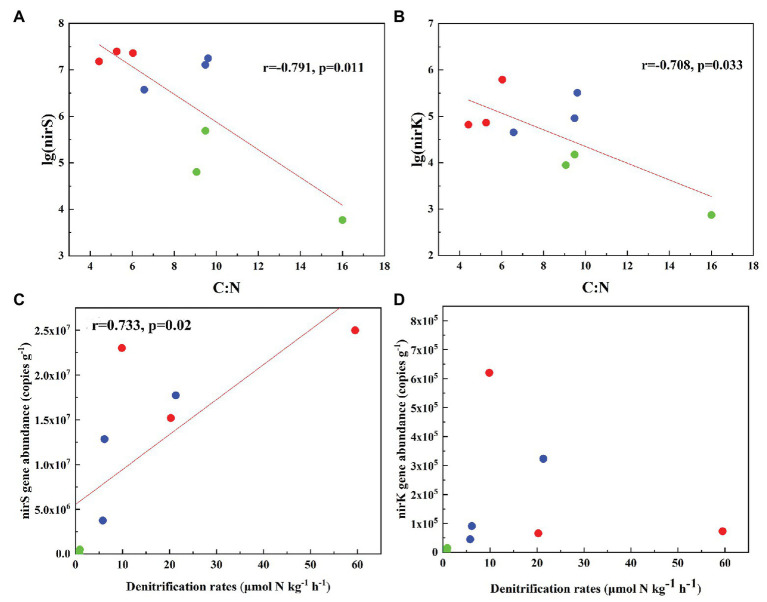
Pearson’s correlation between nirS and nirK genes abundances and tundra soil C:N (A,B), and between denitrification rates and nirS, nirK gene abundances (C,D) in tundra soils of maritime Antarctica. The red, blue, and green dots represent the soils from SS, PS, and AL sites, respectively.